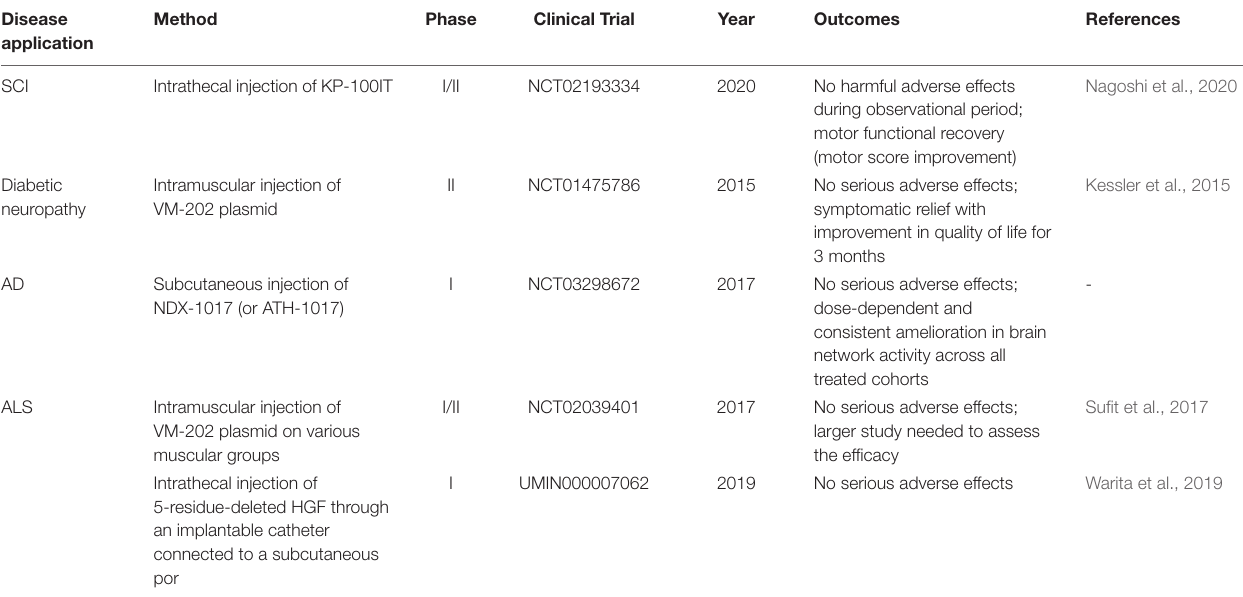
TABLE 3 | Human clinical trials of HGF-based therapy in neurological diseases. Disease